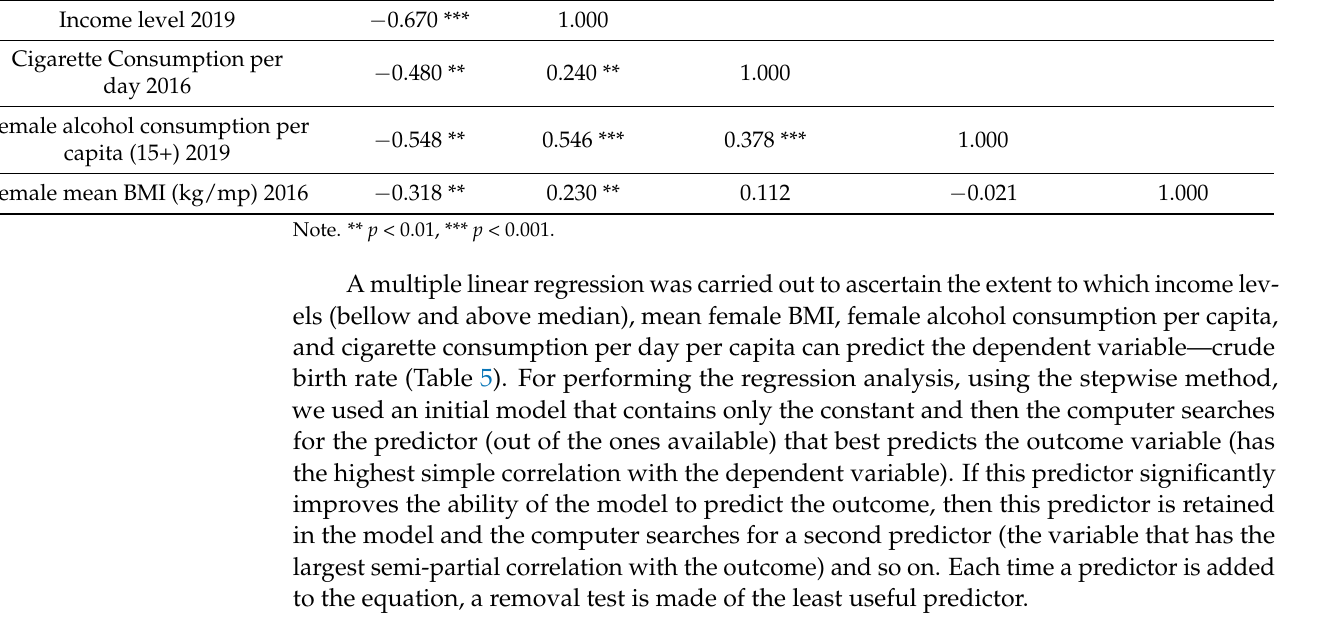
Table 5. Summary of the estimated regression